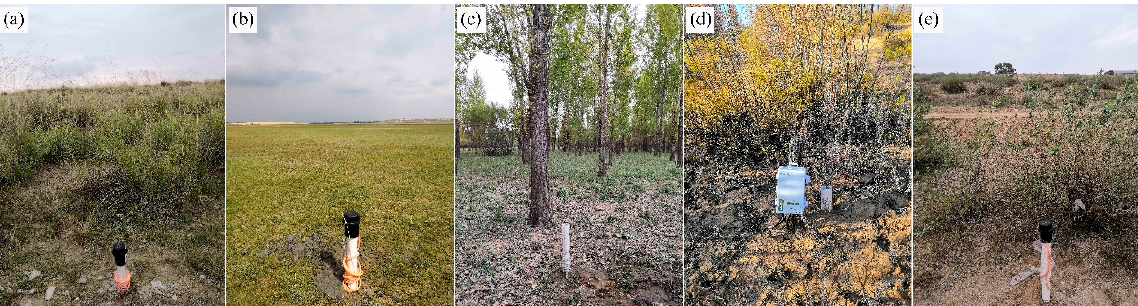
Figure 1. Location map of the study site showing the observation wells and meteorological station.